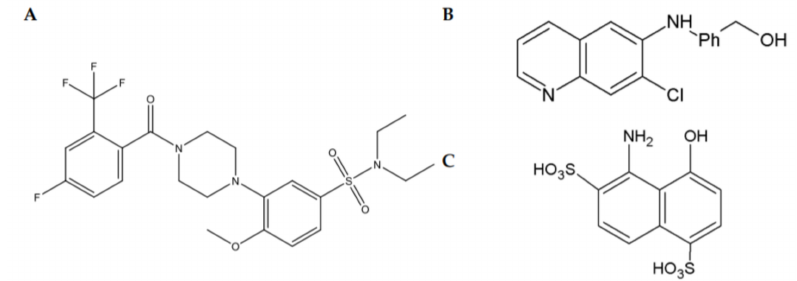
Figure 4. Chemical structures of RET agonists belonging to piperazine-sulfonamides ( A ); quinoline ( B ) and hydroxynaphthalene ( C ) sca ff